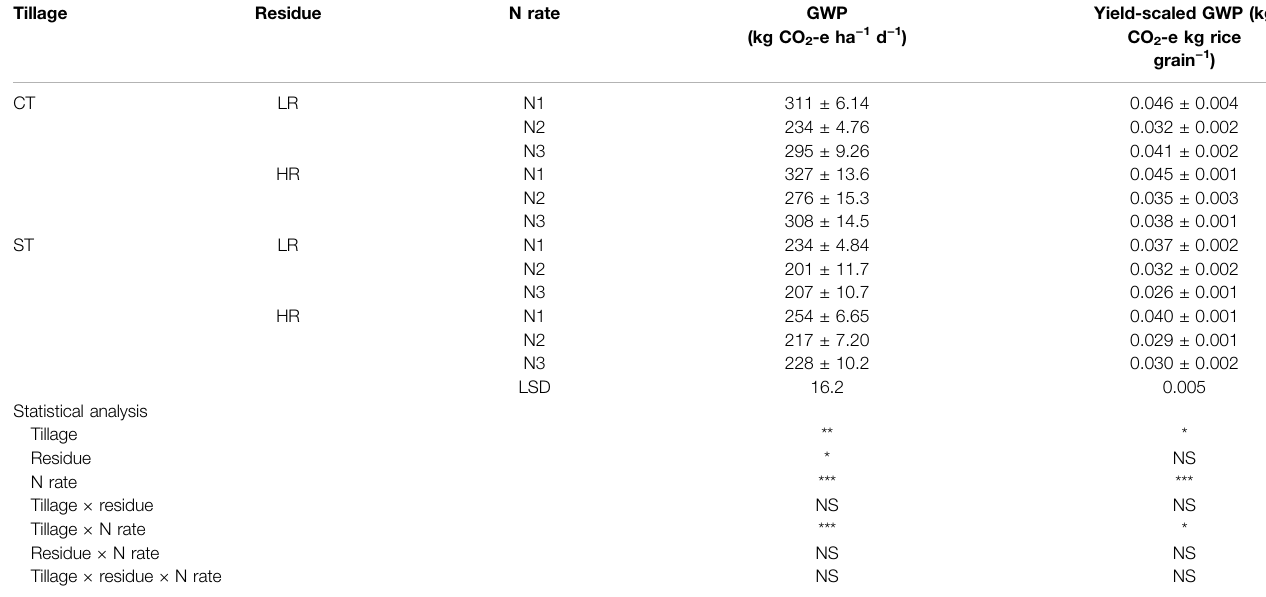
TABLE 3| Effectoftillage systems(conventionaltillage,CTandstriptillage,ST),residuelevels(lowresidue, LRandhighresidue, HR),and Napplicationrates(108,144,and 180 kg ha − 1 ) on global warming potential (GWP) and yield-scaled GWP of CH 4 and N 2 O emissions in Boro rice ( n = 3; mean ± SE).